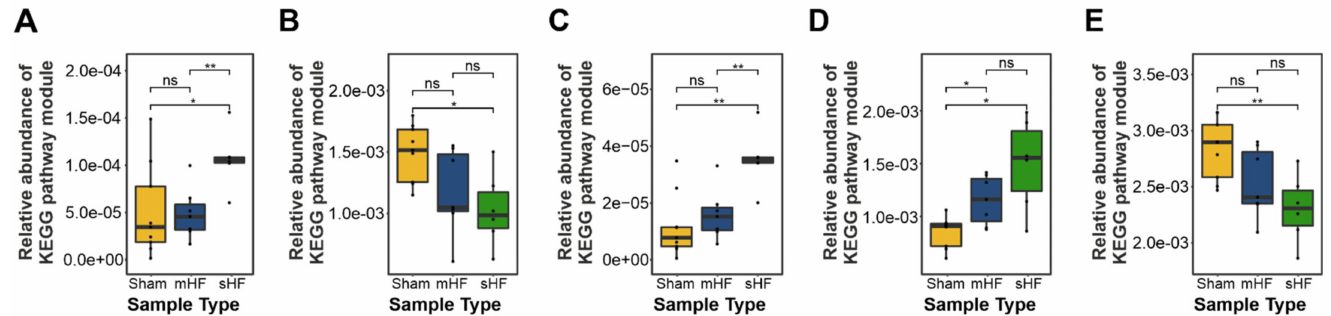
Figure 7. Box plots showing the differentially abundant KEGG pathway modules for amino acid metabolism. ( A ) Branched-chain amino acid degradation-related genes in the sHF, mHF, and Sham samples (Kruskal–Wallis test p -value = 0.001). ( B ) Aromatic amino acid metabolism in the sHF, mHF, and Sham samples (Kruskal–Wallis test p -value = 0.024). ( C ) Aromatic amino acid biosynthesis in the sHF, mHF, and Sham samples ( p -value = 0.012). ( D ) Positively charged amino acid degradation in the sHF, mHF, and Sham samples (Kruskal–Wallis test p -value = 0.036). ( E ) Positively charged